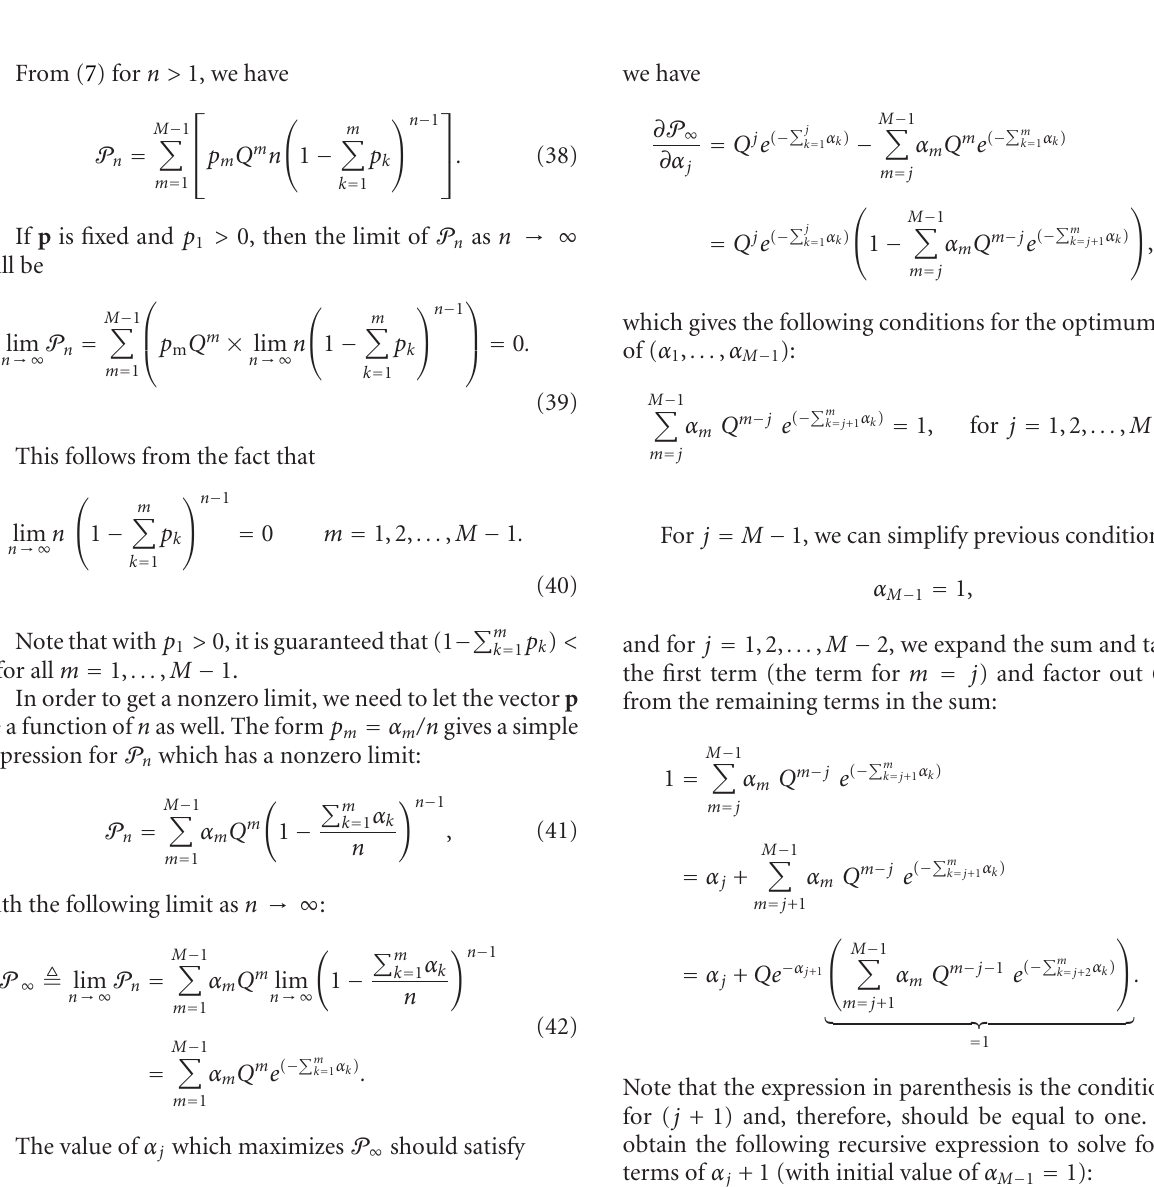
Figure 5: Expected number of time slots to collect all message or first message for N = 50, M = 3, and Q = 0 . 95.